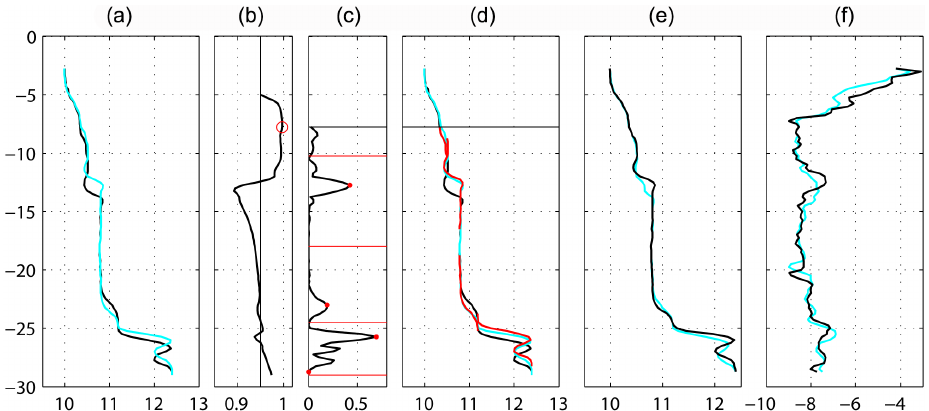
Figure A1. (a) Original temperature profiles used in the realignment algorithm: reference in cyan, profile to be realigned in black. (b) Correlation coefficient computed for progressively longer segments starting form surface. The black vertical line is the 0.95 correlation threshold and the red circle the maximum correlation. (c) Root mean square error between the two profiles; red dots identify peaks. Black horizontal lines divide the segments used for realignment. (d) The realigned segments (thin red lines) above the two original profiles. Panels (e) and (f) show the mean profile for temperature and turbulent kinetic energy dissipation rates computed using the original profiles (cyan) and the realigned ones